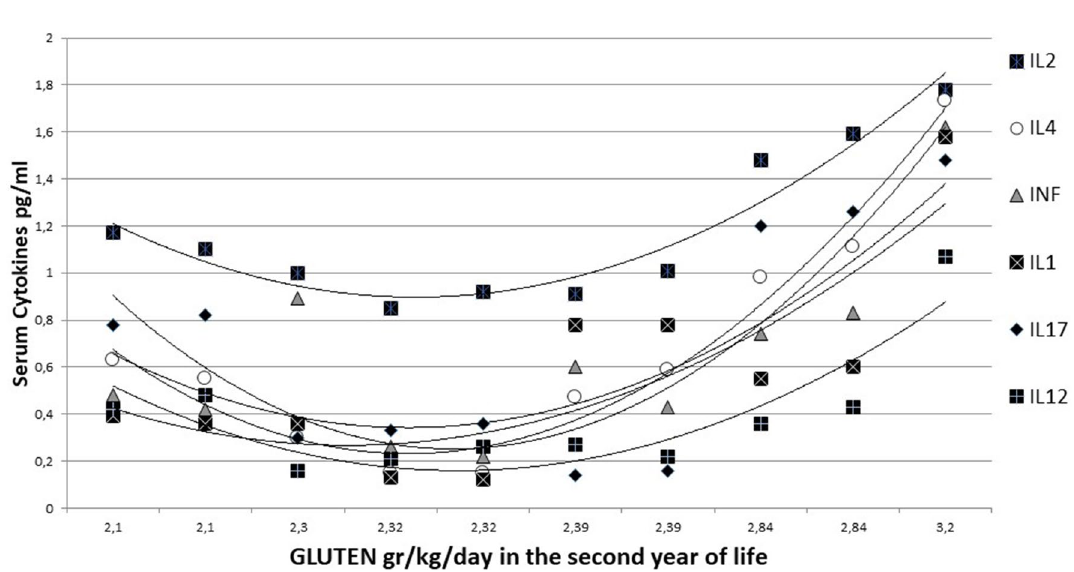
Figure 3. Pearson correlation coefficient ‘r’ between gluten (gr/kg/day) intake in the second year of life and serum cytokines at 36 months in the celiac disease